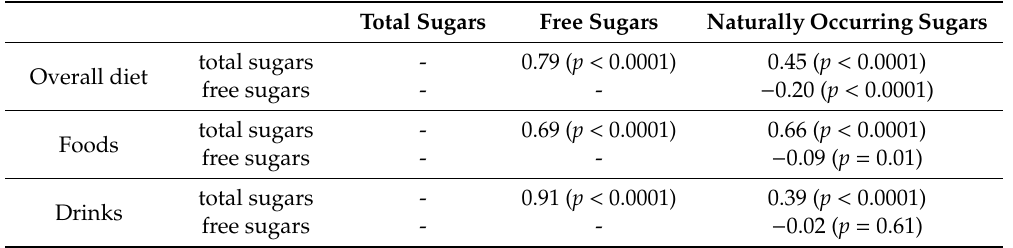
Table 3. Correlations between %E from total, free and naturally occurring sugars in overall diet and in foods and drinks separately in a representative sample of French-speaking adults of the Province of Qu é bec, Canada. Total Sugars Free Sugars Naturally Occurring Sugars total sugars - 0.79 ( p < 0.0001) 0.45 ( p < 0.0001) Overall diet